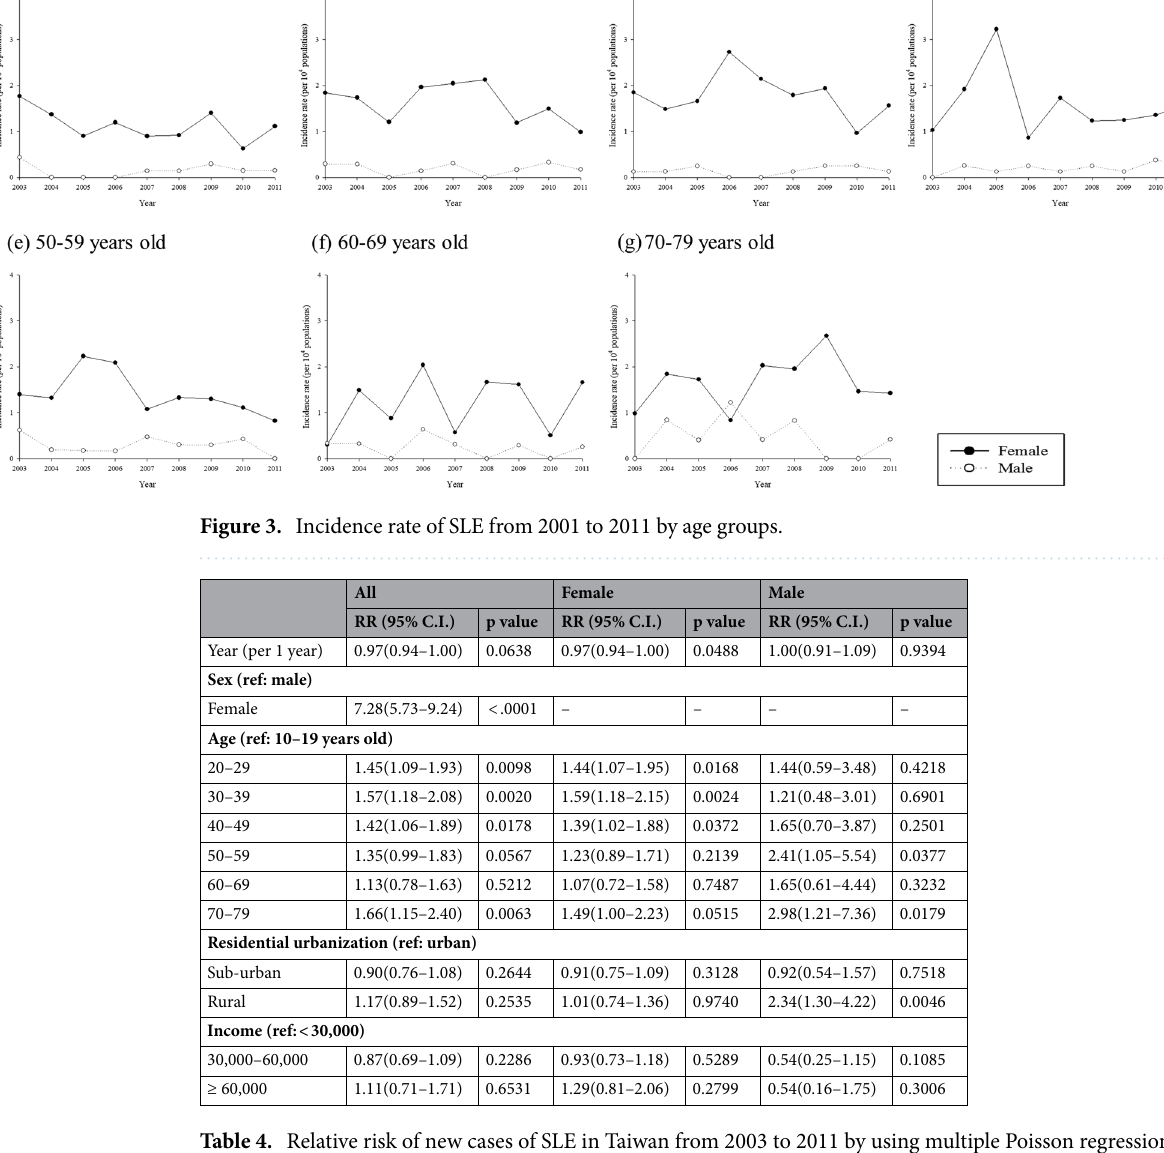
Table 4. Relative risk of new cases of SLE in Taiwan from 2003 to 2011 by using multiple Poisson regression*. *Models were adjusted for calendar year, sex, age groups, urbanization and income levels.